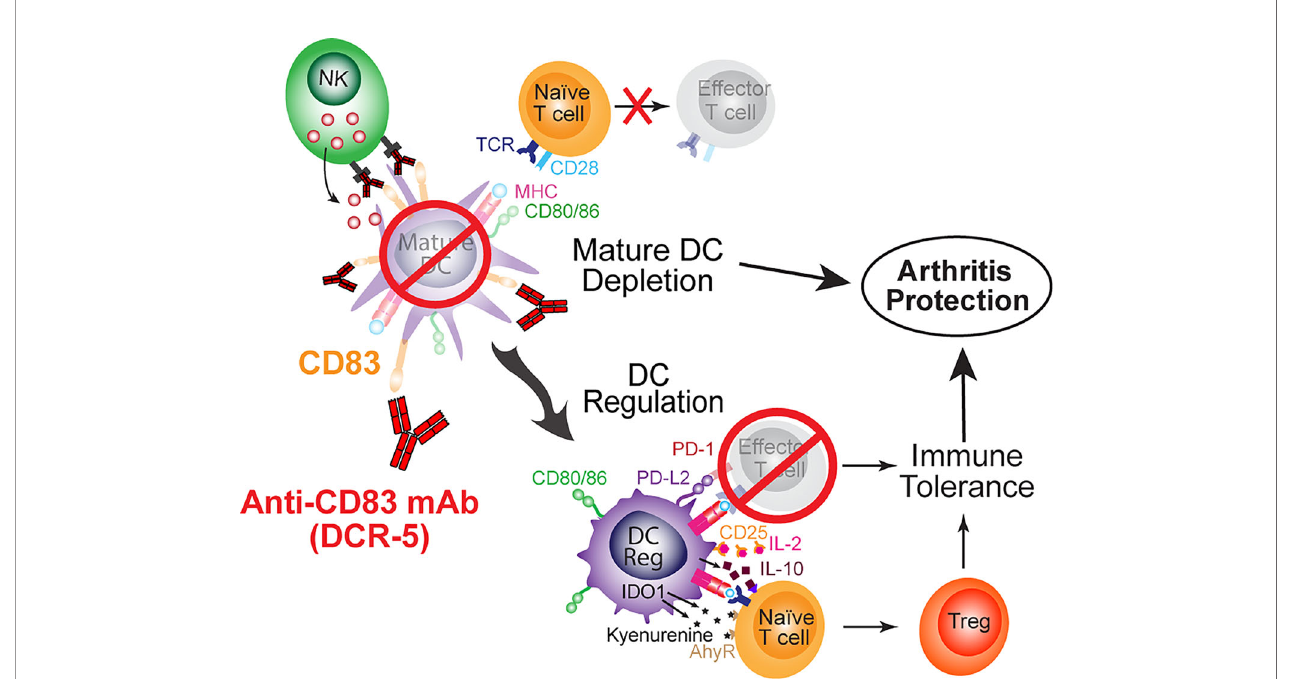
FIGURE 11 | Schematic of mechanisms of anti-CD83 mAb mediated immune suppression leading to protection from